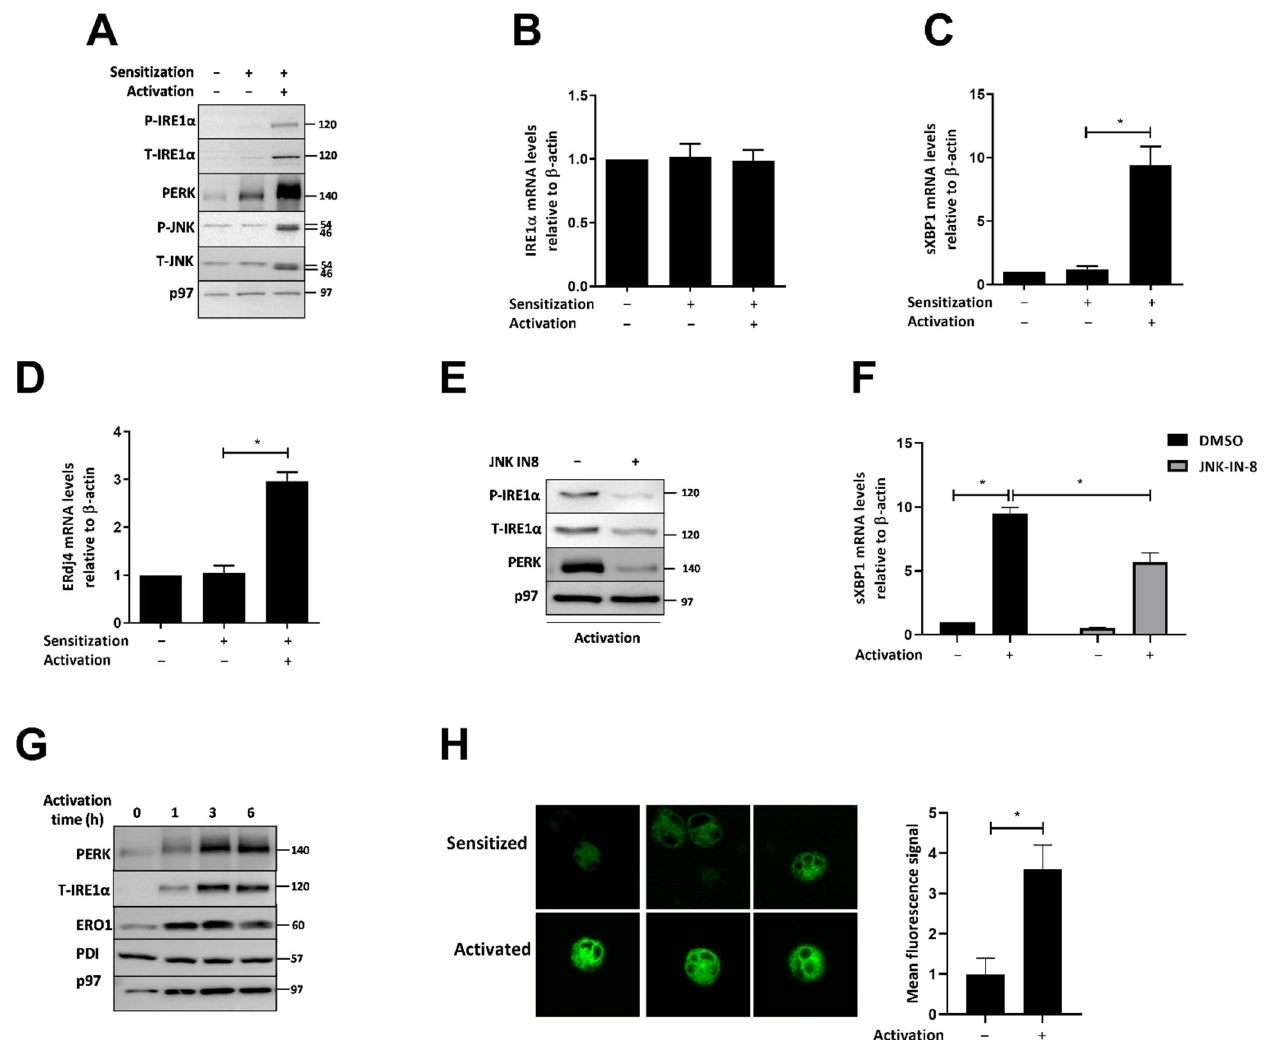
Figure 1. Activation of CBMCs promotes expression of IRE1 α and PERK. CBMCs were sensitized by culturing them with human myeloma IgE (0.3 µ g/mL). Three days later, cells were activated by rabbit anti-human IgE Ab (5 µ g/mL, 4 h). ( A ) Equal amounts of whole cell extracts were analyzed by immunoblotting for phosphorylated and total IRE1 α , PERK, phosphorylated and total JNK, and p97 as a loading control. A representative image of three independent experiments is shown. RT-qPCR analyses of ( B ) IRE1 α , ( C ) sXBP1, and ( D ) ERdj4 following the indicated treatments, represented as the mean of three independent experiments normalized to β -actin ± SD. * p < 0.05. ( E ) IgE-sensitized CBMCs were pretreated with 3 µ M JNK-IN-8 for 1 h, followed by activation with rabbit anti-human IgE Ab (5 µ g/mL, 4 h). Equal amounts of whole cell extracts were analyzed by immunoblotting for phosphorylated and total IRE1 α , PERK, and p97 as a loading control. ( F ) RT-qPCR analysis of sXBP1 following the indicated treatments, represented as the mean of relative mRNA levels normalized to β -actin ± SD, * p < 0.05. ( G ) CBMCs were sensitized with human myeloma IgE (0.3 µ g/mL, 3 days), followed by activation with rabbit anti-human IgE Ab (5 µ g/mL) for 1, 3, and 6 h. Equal amounts of whole cell extracts were analyzed by immunoblotting for PERK, total IRE1, ERO1, PDI, and p97 as a loading control. A representative image of three independent experiments is shown. ( H ) Fluorescence of ER-Tracker (green marker) in CBMCs following IgE-mediated activation for 4 h, analyzed by confocal microscopy (60 × with immersion oil). The fluorescence signal from 50 cells was quantified. Data are expressed as mean intensity ± SD. * p < 0.05.